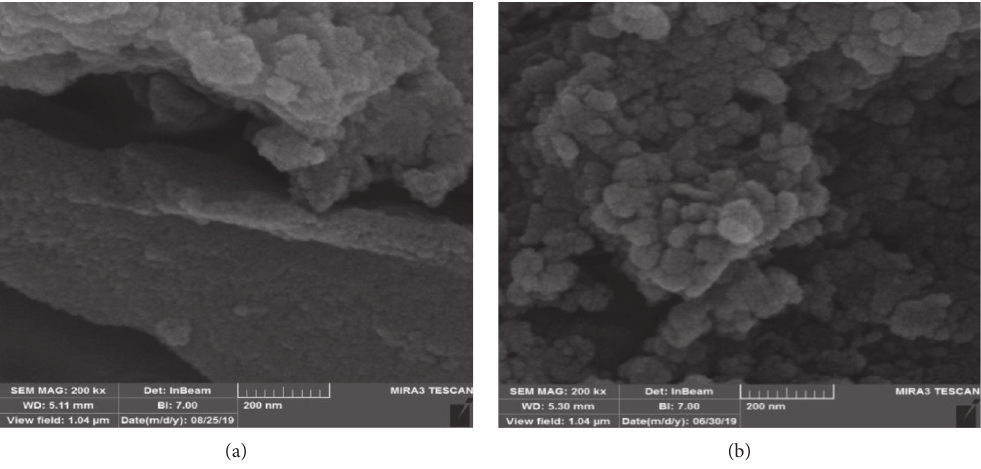
Figure 5: SEM images of GO/Al